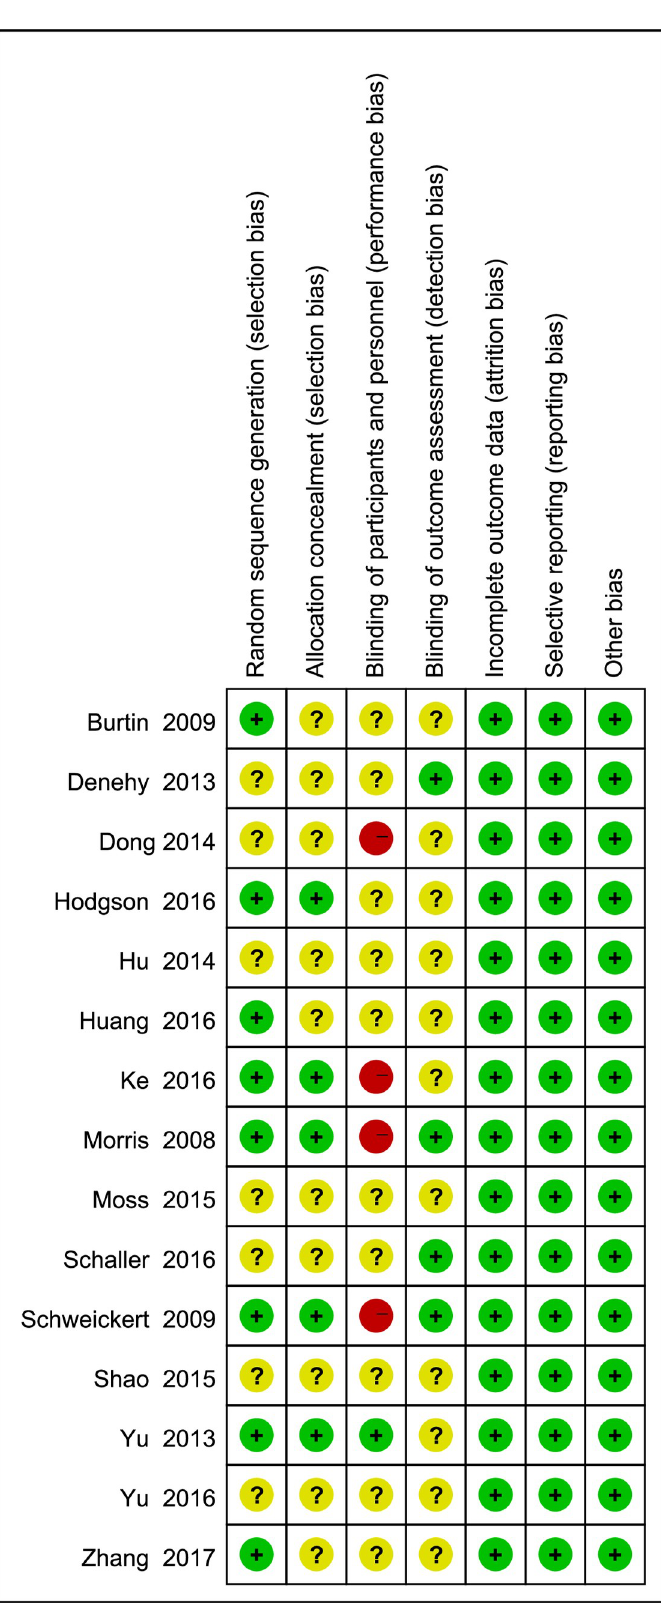
Fig 2. Green: Low risk of bias; Yellow: Unclear risk of bias; Red: High risk of bias. https://doi.org/10.1371/journal.pone.0223151.g002 PLOS ONE | https://doi.org/10.1371/journal.pone.0223151 October 7,